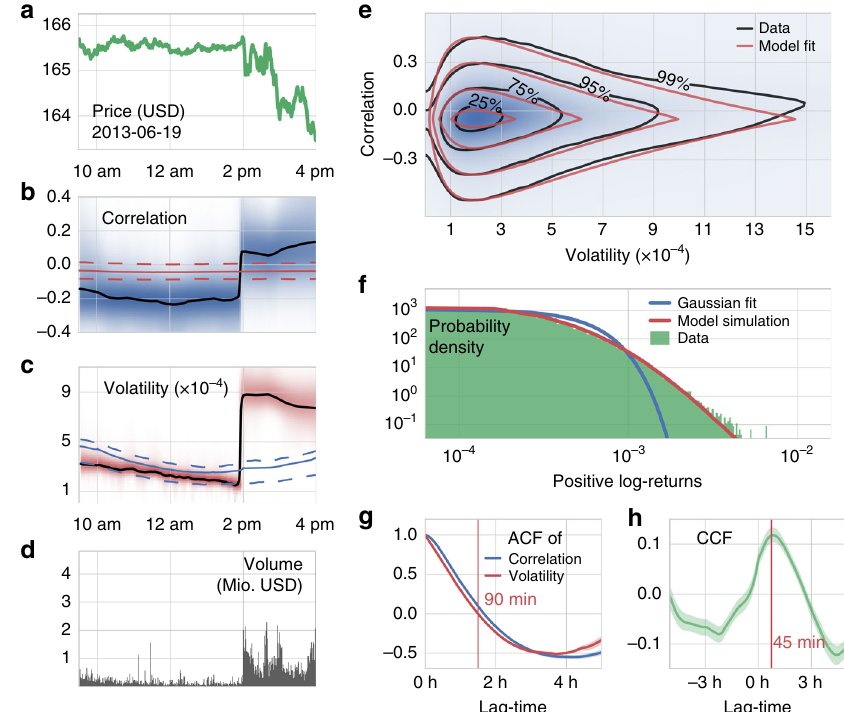
Fig. 4 Heterogeneity in intra-day price fl uctuations. a Price evolution of SPY on June 19th, 2013. b Inferred temporal evolution of the mean correlation (black line) and the corresponding parameter distribution (blue shading). Red line and dashed lines represent the average daily temporal evolution of the mean correlation and its inter-quartile range, respectively. c Inferred temporal evolution of the mean volatility (black line) and the corresponding parameter distribution (red shading). Blue line and dashed lines represent the average daily temporal evolution of the mean volatility and its inter-quartile range, respectively. d Minute-scale trading volume of SPY. e Joint distribution of correlation and volatility, based on the heterogeneous random walk model (black lines; blue shading) and the corresponding fi t using analytical distributions (red lines). f Histogram of positive minute log-returns from the 2011 to 2015 of the exchange-traded fund SPY (green), together with the best fi t Gaussian distribution of the data (blue line) and the simulated distribution of log-returns from the heterogeneous model (red line). g Auto-correlation functions of the two model parameters, correlation (blue) and volatility (red). h Parameter cross-correlation as a function of lag-time. Positive lag-times correspond to a comparison of future volatility values to current correlation values. The shading in g , h corresponds to 1